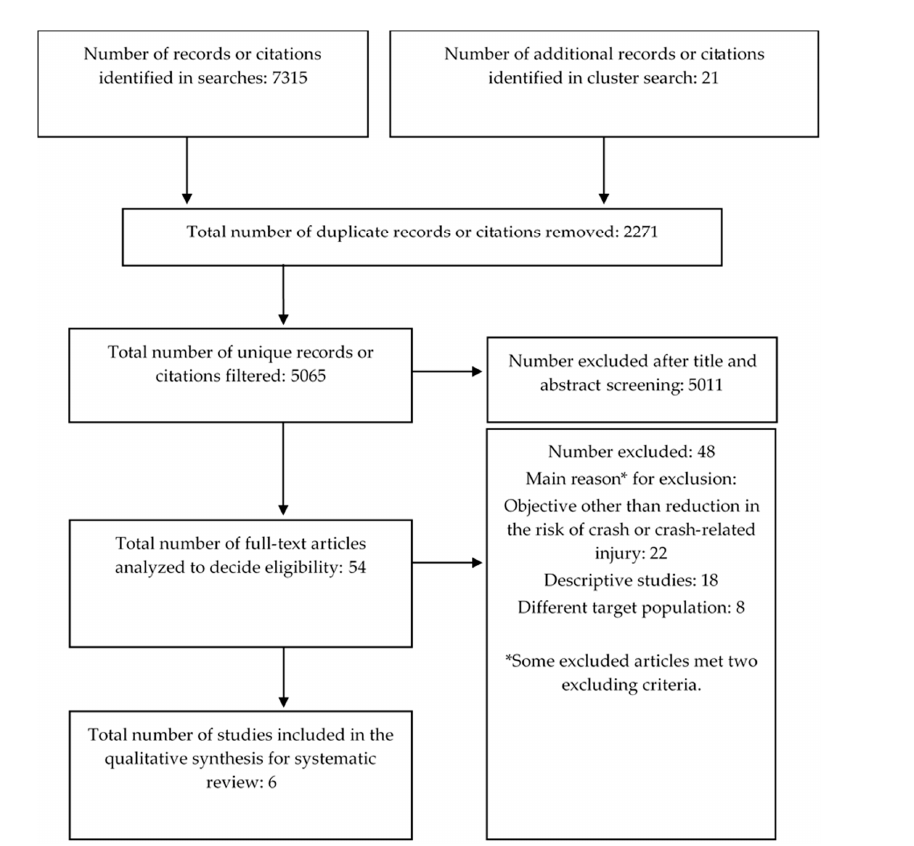
Figure 1. Flowchart of the article selection process.